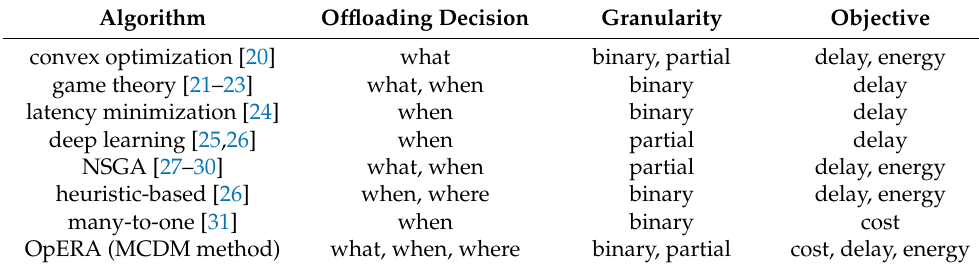
Table 2. A comparison of existing offloading research approaches.